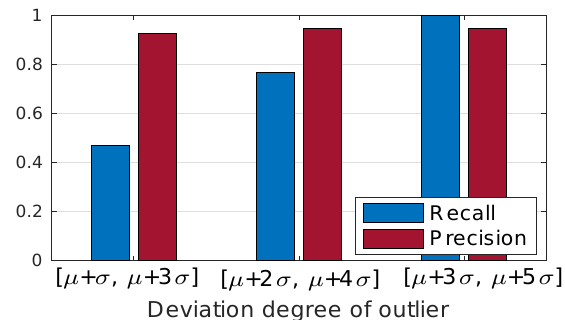
Figure 6. The changes of recall and precision with deviation degree of